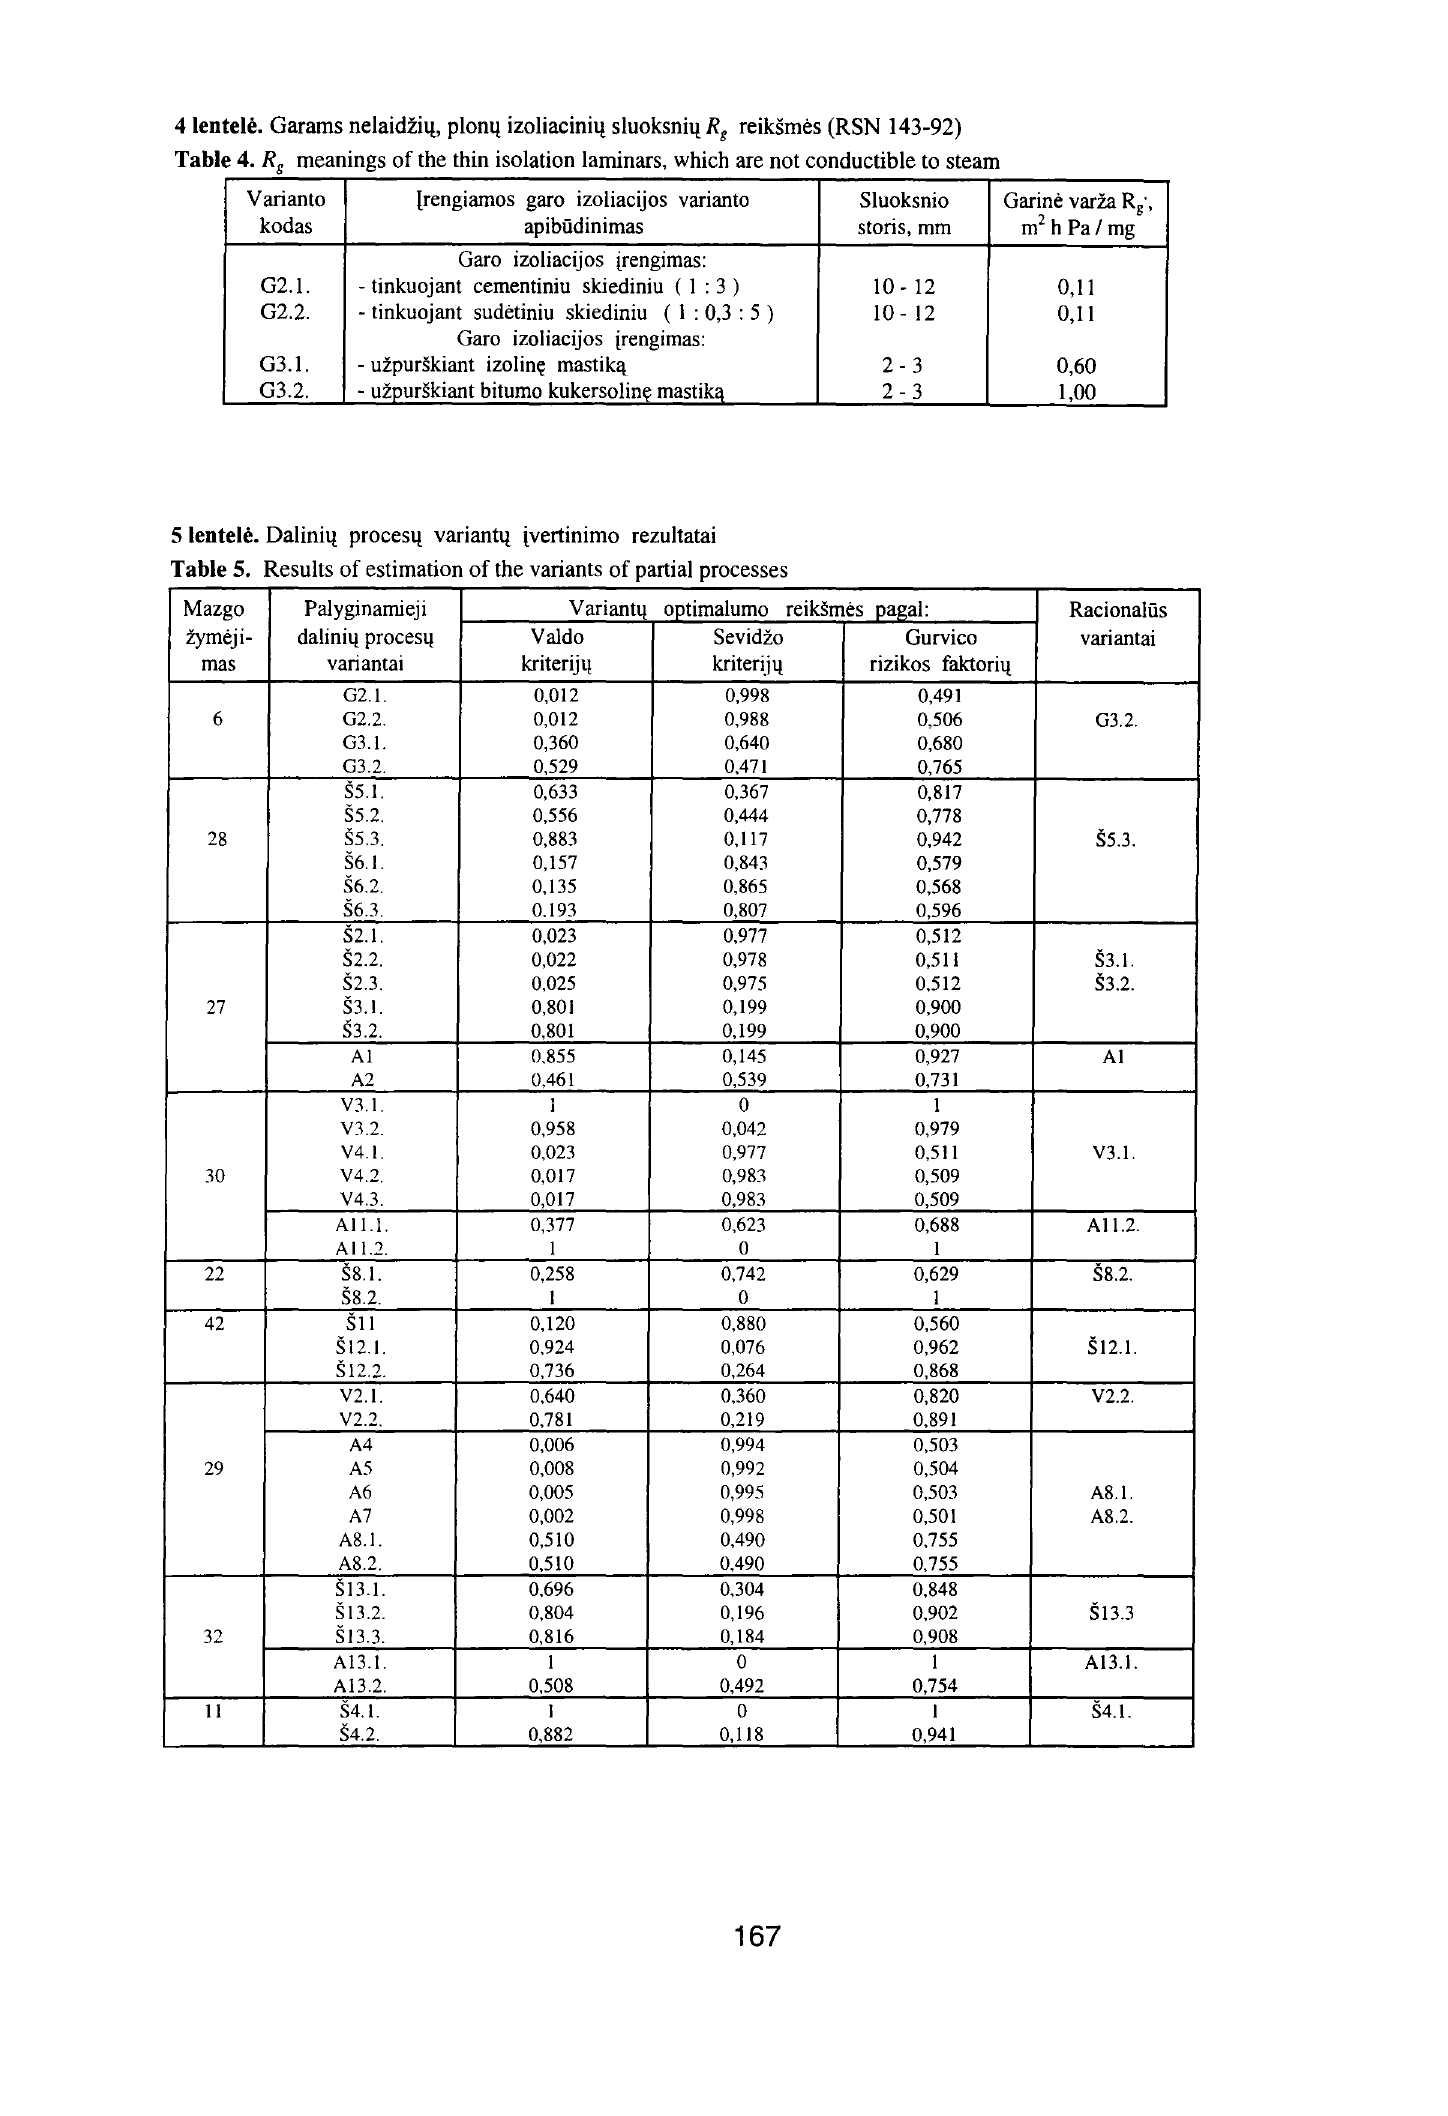
Table 4. Rg meanings of the thin isolation laminars, which are not conductible to steam